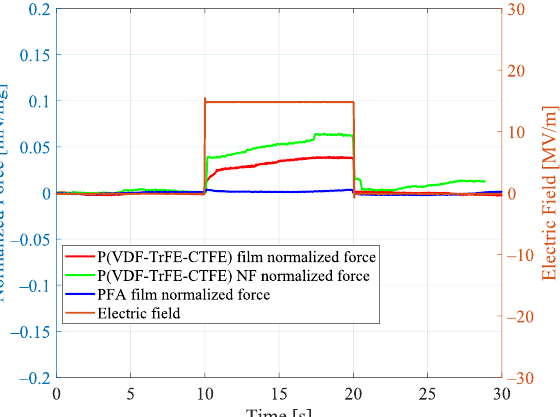
Figure 9. Normalized contraction forces in the uniaxial load test for the P(VDF-TrFE-CTFE) film, the P(VDF-TrFE-CTFE) NF nanofibers mat, and the PFA